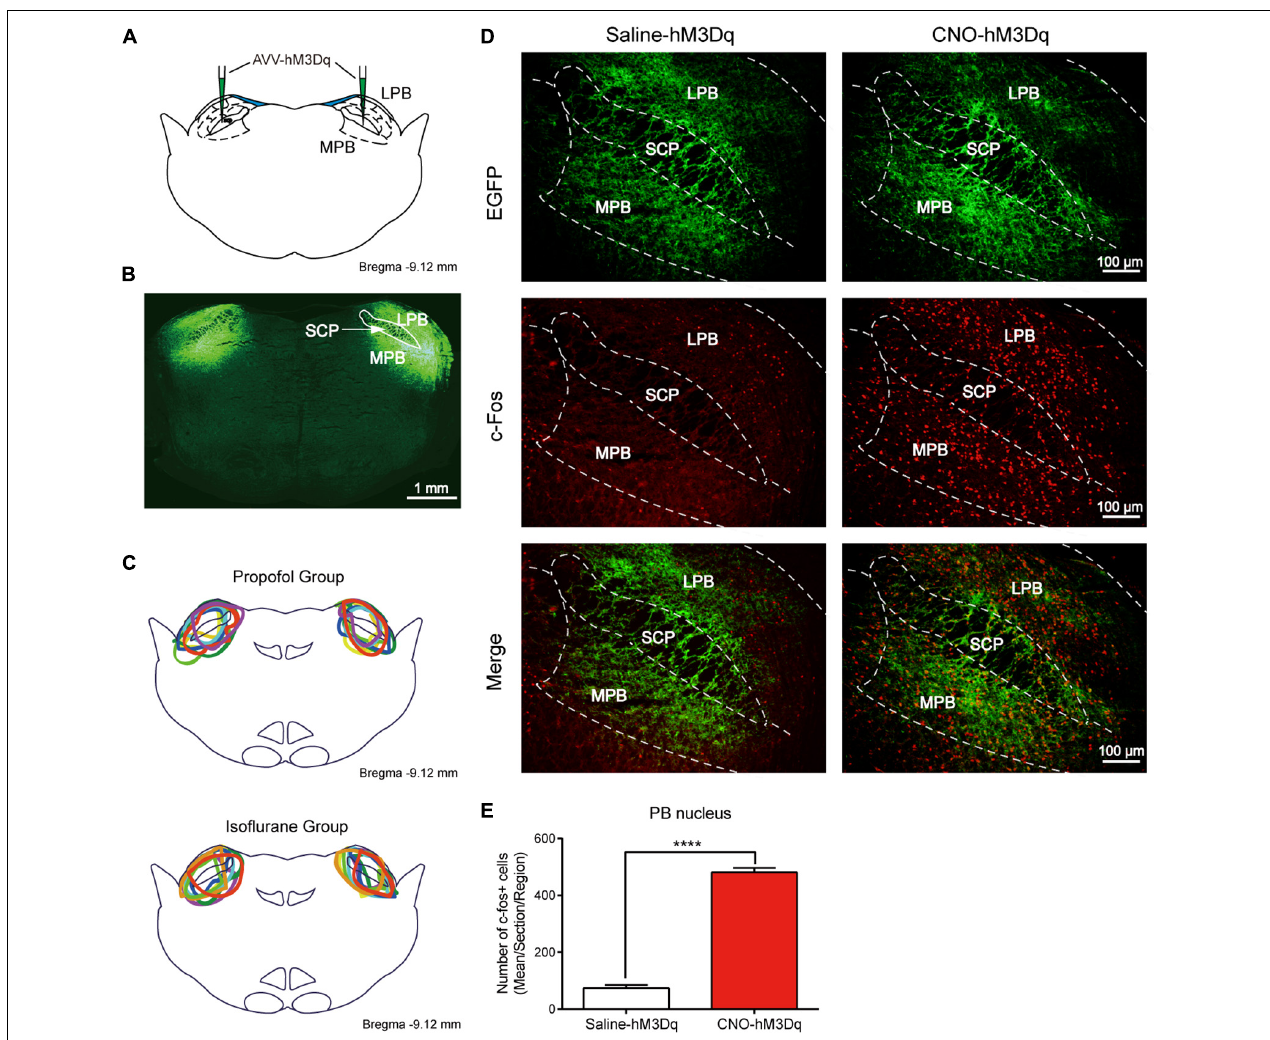
FIGURE 2 | Expression of the hM3Dq receptors in PBN neurons and activation of neurons with CNO. (A) Coronal section showing the injection sites of AAV-hSyn-hM3Dq-EGFP or AAV-hSyn-EGFP in the PBN. (B) Outline of hM3Dq-EGFP in PBN nucleus. (C) Expressions of hM3Dq receptors in PBN from each case are outlined in the propofol group ( n = 8) and the isoflurane group ( n = 8). (D) c-Fos expression in PBN neurons after hM3Dq rats received CNO or saline i.p. injection. Three rats for each group (2–4 sections per rat). Bar = 100 µ m. (E) Mean number of c-Fos positive cells in PBN nucleus. Data are described as mean ± SEM. c-Fos expression in PBN neurons with CNO pretreatment was significantly higher than in the saline pretreatment group ( p < 0.0001, unpaired t -test). LPB, lateral parabrachial nucleus; SCP, superior cerebellar peduncle; MPB, medial parabrachial